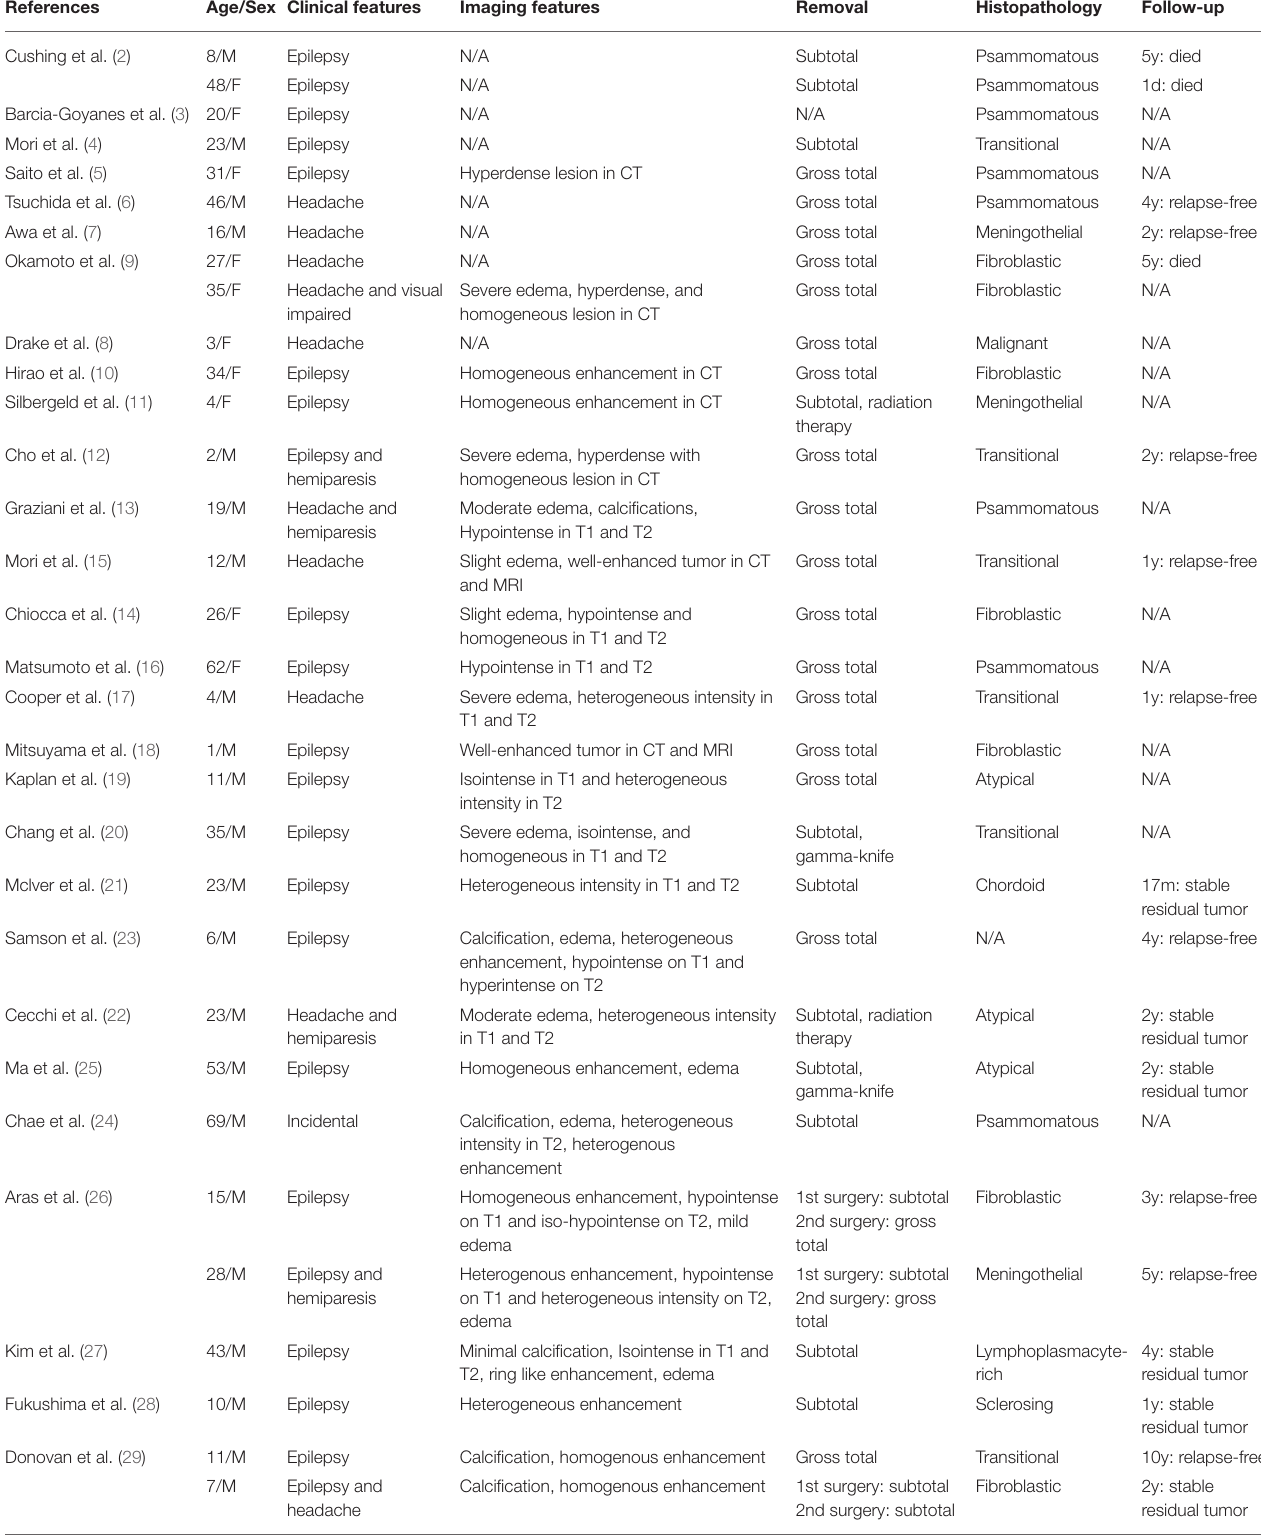
TABLE 1 | Summary of Sylvian fissure meningiomas up to October 31, 2019.